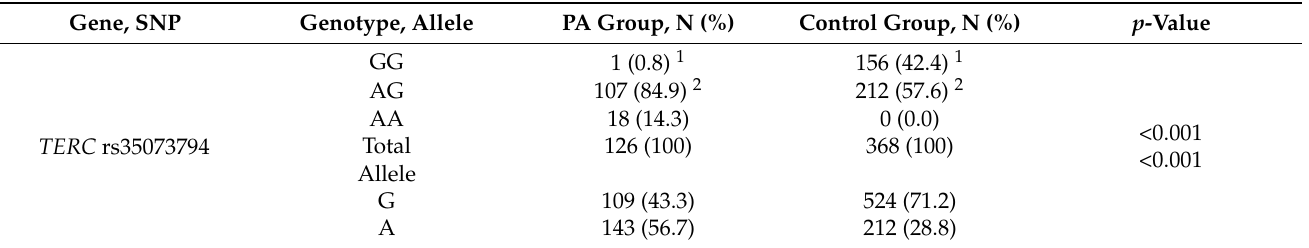
Table 2. Genotype and allele frequencies of single nucleotide polymorphism ( TERC rs35073794) within PA and control